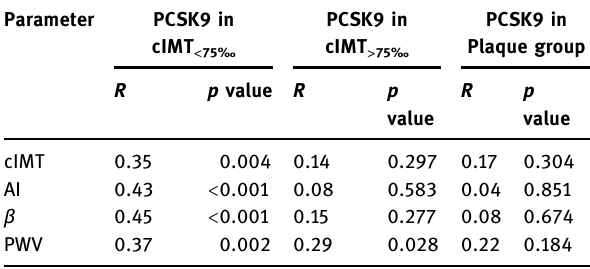
Table 6: Relationship between the subclinical vascular changes and PCSK9 concentrations in di ff erent groups of patients according to the severity of vascular changes Parameter PCSK9 in PCSK9 in PCSK9 in cIMT < 75 ‰ Plaque